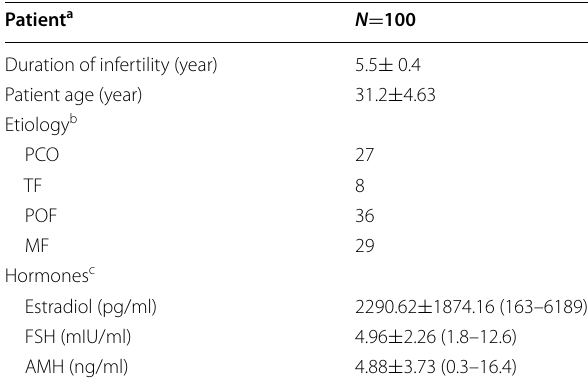
Table 1 The demographic, etiologic, and hormonal information of patients between two control and case